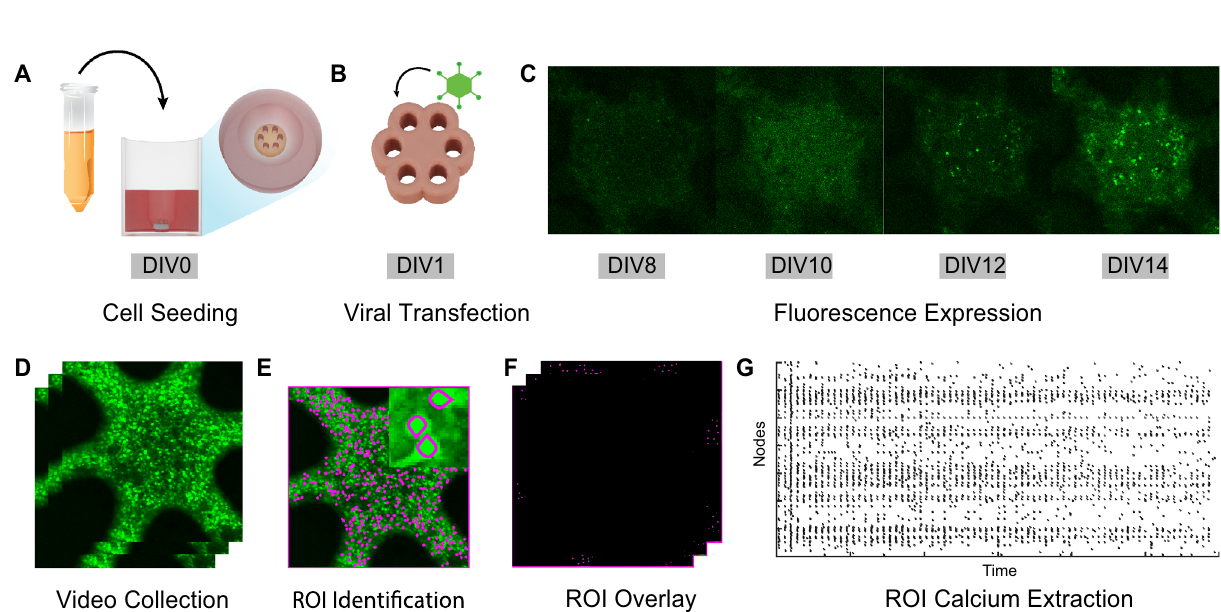
Figure 2. Three-dimensional self-assembled neural cultures express stable GcaMP6s fluorescence and exhibit spontaneous activity by DIV 14. ( A ) Dissociated P1 primary rat cells are seeded into a custom injection molded agarose well. ( B ) Cells, which form a “microtissue” (tan) in the first 24 h, were transfected with a commercially available viral vector to encode the GcaMP6s calcium indicator (AAV1-hSyn1-mRuby2-GSG-P2A-GcaMP6s- WPRE-pA). ( C ) Microtissues display progressive expression of baseline calcium fluorescence from DIV 8— DIV14. ( D ) Time-lapse videos of calcium transients were collected for 4 min. ( E ) Python code was used to perform semi-automated segmentation of cell bodies. ( F ) Segmented regions of interest (ROIs) were overlaid onto the 4-min video for single-cell calcium trace extraction. ( G ) A raster plot of calcium events detected from calcium traces were extracted from segmented videos using the FluoroSNNAP application 40